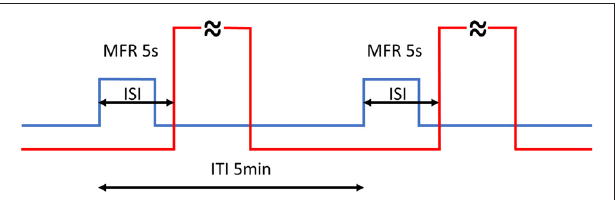
FIGURE 1 | Timing of the training. Every rotation of magnetic North (MFR; blue line) lasted 5 s and was followed by 60 s hot air stream (red line—abridged). Back and forth rotations by 60 ◦ alternated periodically every 5 min (ITI). The whole training consisted of 20 training cycles in total, split into two blocks. The inter-stimulus intervals (ISIs) is the time between the start of MFR and onset of hot air stream. Different ISIs ( − 2, 0, 1, 2, 3, 5, 8 and 28 s) were